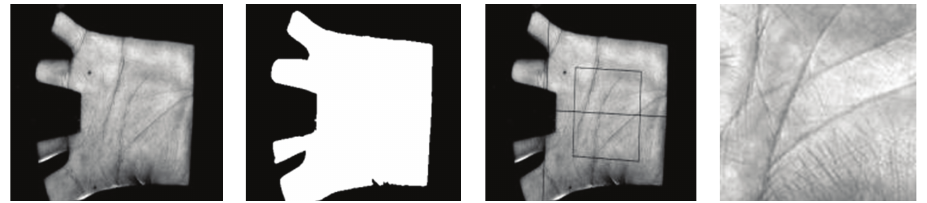
Figure 3: Images from the IIT Delhi